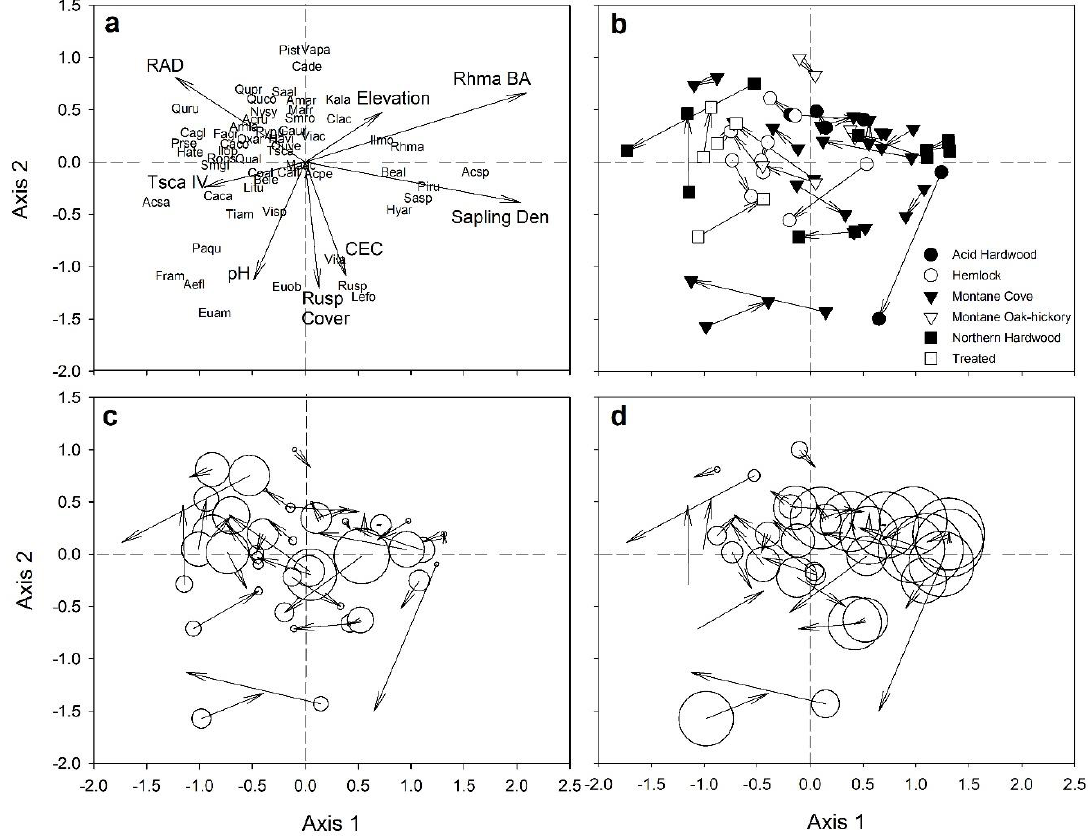
Figure 3. NMDS ordination of seedling species relative density: ( a ) Biplot of seedling species in 2017; significant (α = 0.1) environmental variables RAD (total potential incident radiation), Elevation, Rhma BA ( R. maximum basal area), Sapling Den (total sapling density), CEC (cation exchange capacity), Rusp Cover (percent cover of Rubus spp.), pH (soil pH), and Tsca IV (pre-HWA overstory importance value of T. canadensis ) are shown as vectors; ( b ) Successional vectors indicating change in composition from 2003 (pre-HWA) to 2017 (post-HWA) by ecogroup; ( c ) Successional vectors showing compositional change and bubble plot showing change in overstory T. canadensis IV between 2003 and 2017; and ( d ) Successional vectors showing compositional change and bubble plot showing relative density of R. maximum in 2003. Species abbreviations: Acpe = Acer pensylvanicum L., Acru = Acer rubrum , Acsa = Acer saccharum , Acsp = Acer spicatum , Aefl = Aesculus flava , Amar = Amelanchier